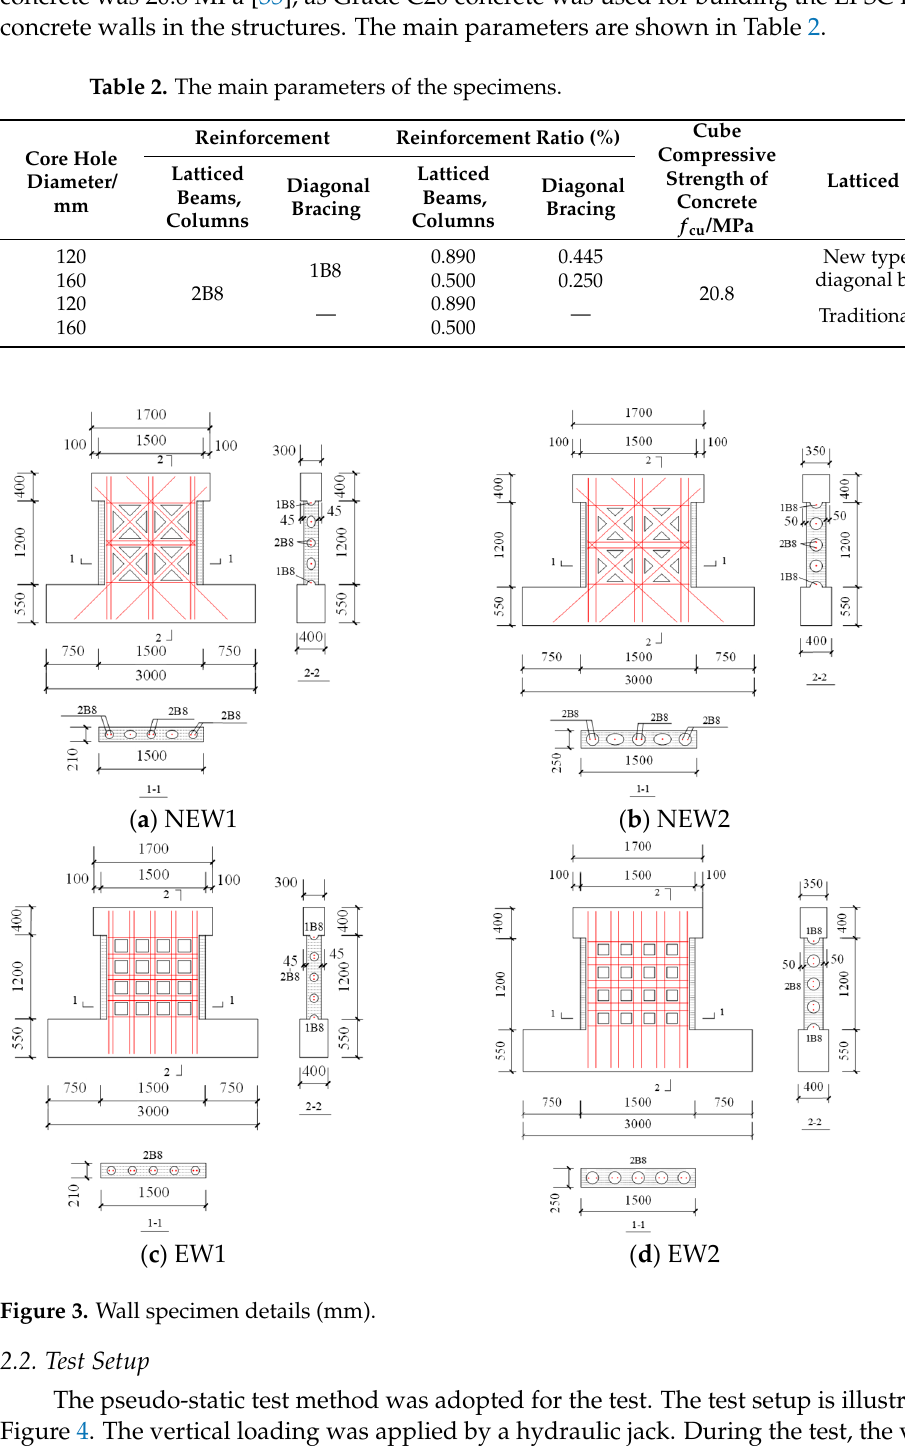
Table 2. The main parameters of the specimens.